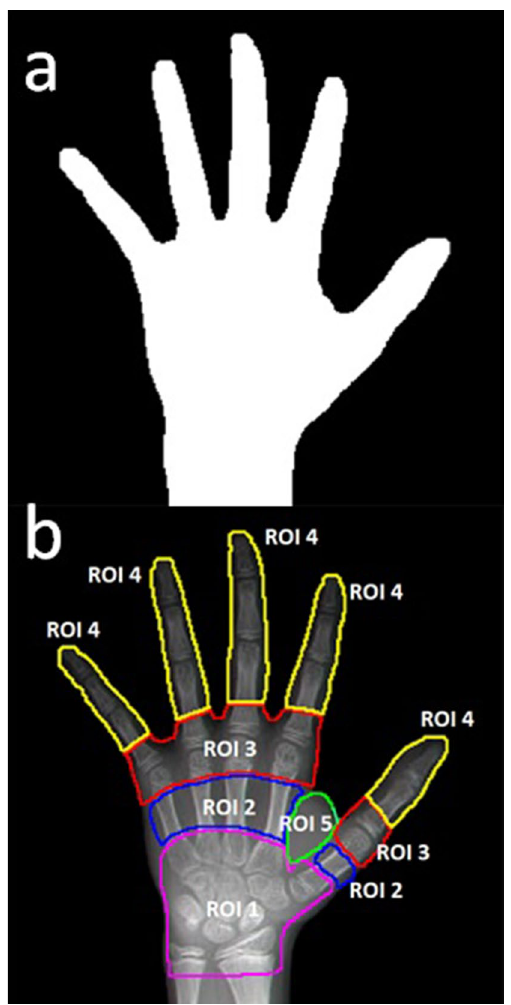
Figure 1. ( a ) A binary mask was generated for all hand images. Outside the hand, the image intensity was set to zero. ( b ) Five ROIs were drawn. ROI 1 covered the wrist area, including carpal bones, the distal ends of the radius and ulna, and the proximal end portions of metacarpal bones; ROI 2 comprised the middle section of the 5 metacarpal bones; ROI 3 comprised the 5 joints connecting metacarpal bones and proximal phalanges; ROI 4 included all areas of phalanges excluding the proximal ends of the proximal phalanges; and ROI 5 was a muscle area between the first and second metacarpal bones containing abductor pollicis, adductor pollicis and flexor pollicis. ROIs 2, 3 and 4 consisted of sub-regions that were not